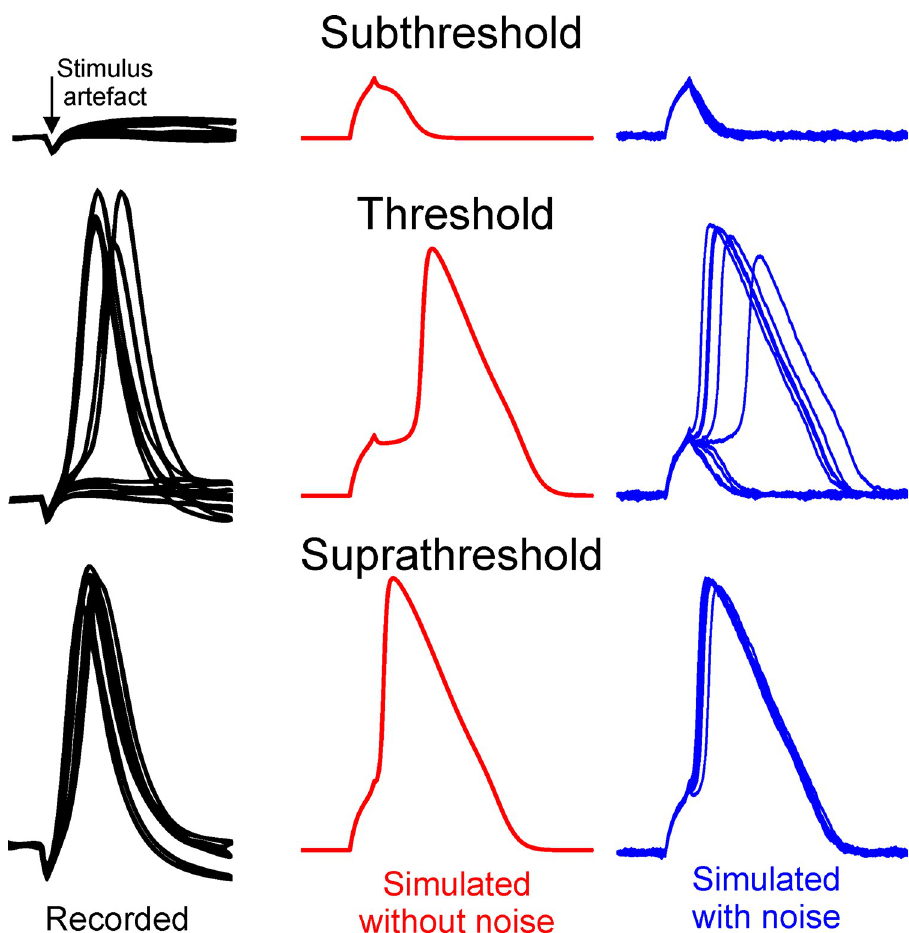
Fig 1. Stochasticity in AP generation under constant stimulation conditions. If 10 pulses are applied at threshold intensity 5 APs are expected but a repetition of the experiment may cause 4 or 7 APs. Stronger stimulation shows a precise response of one AP per pulse (bottom) but still some variation in the spike shapes. In an original model of the HH type (red examples) a noise term is added to include a stochastic behavior (blue). Recorded membrane voltages of retinal ganglion cells were redrawn from [13], simulations were calculated with the CRRSS model.